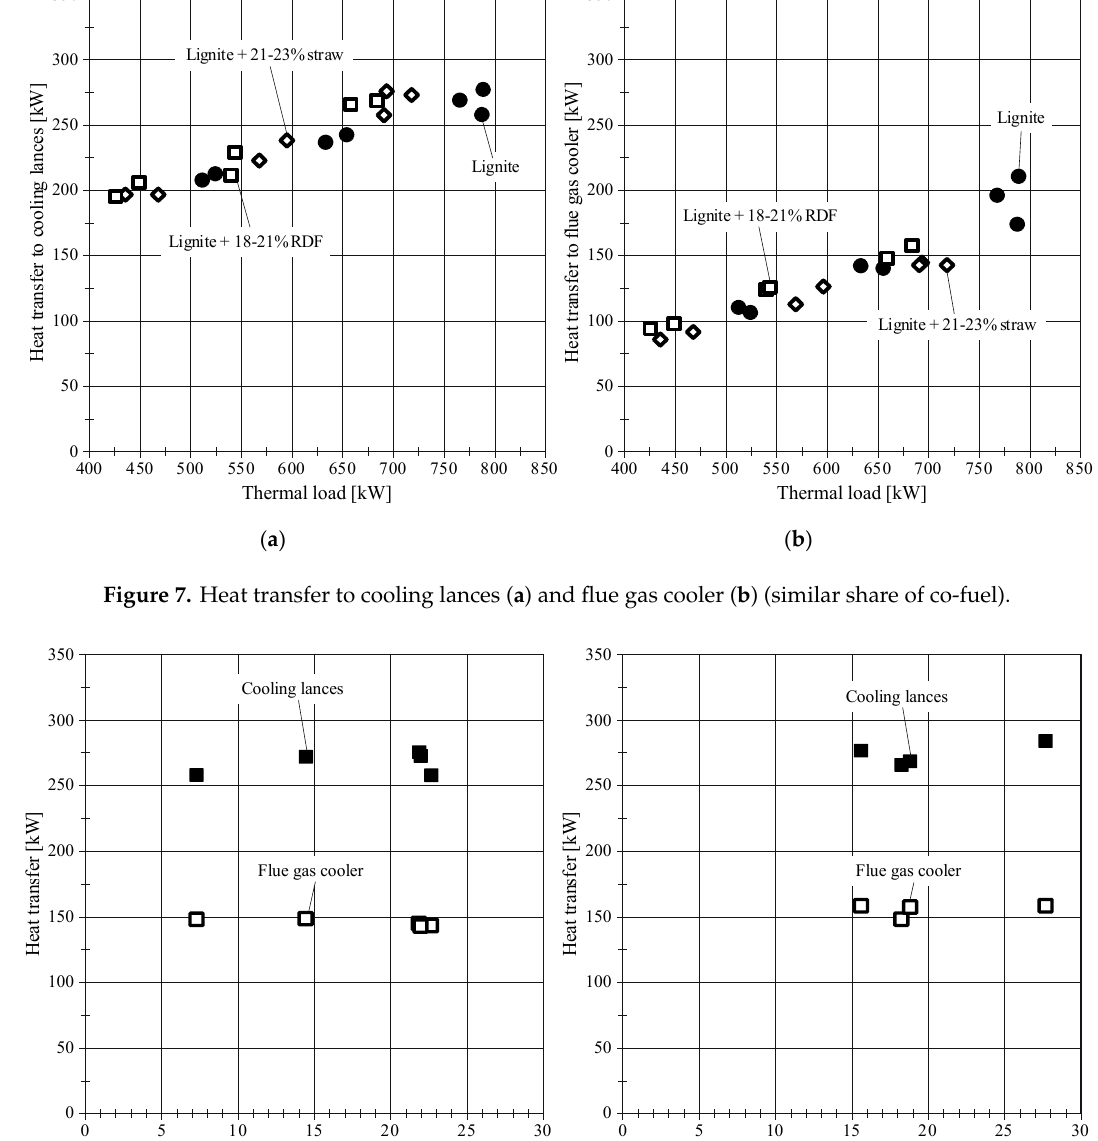
Figure 7. Heat transfer to cooling lances ( a ) and flue gas cooler ( b ) (similar share of co-fuel).